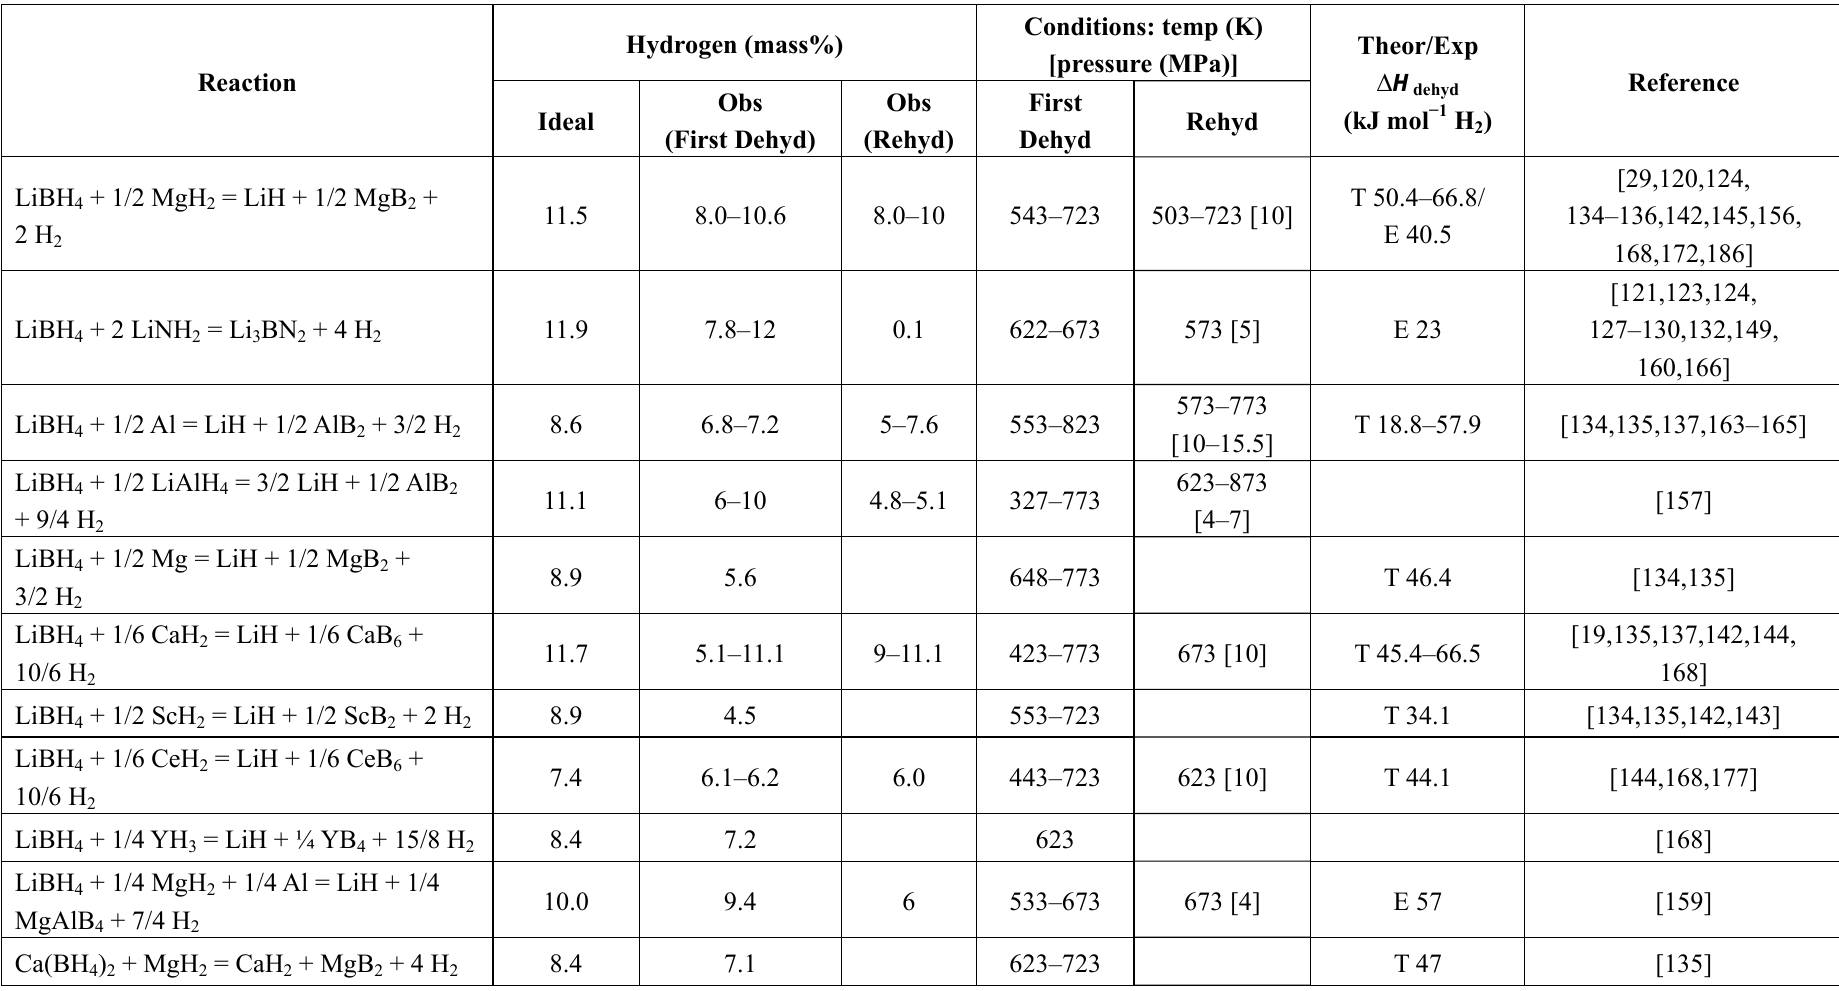
) with metal hydrides, complex hydrides, metals, etc 4 n